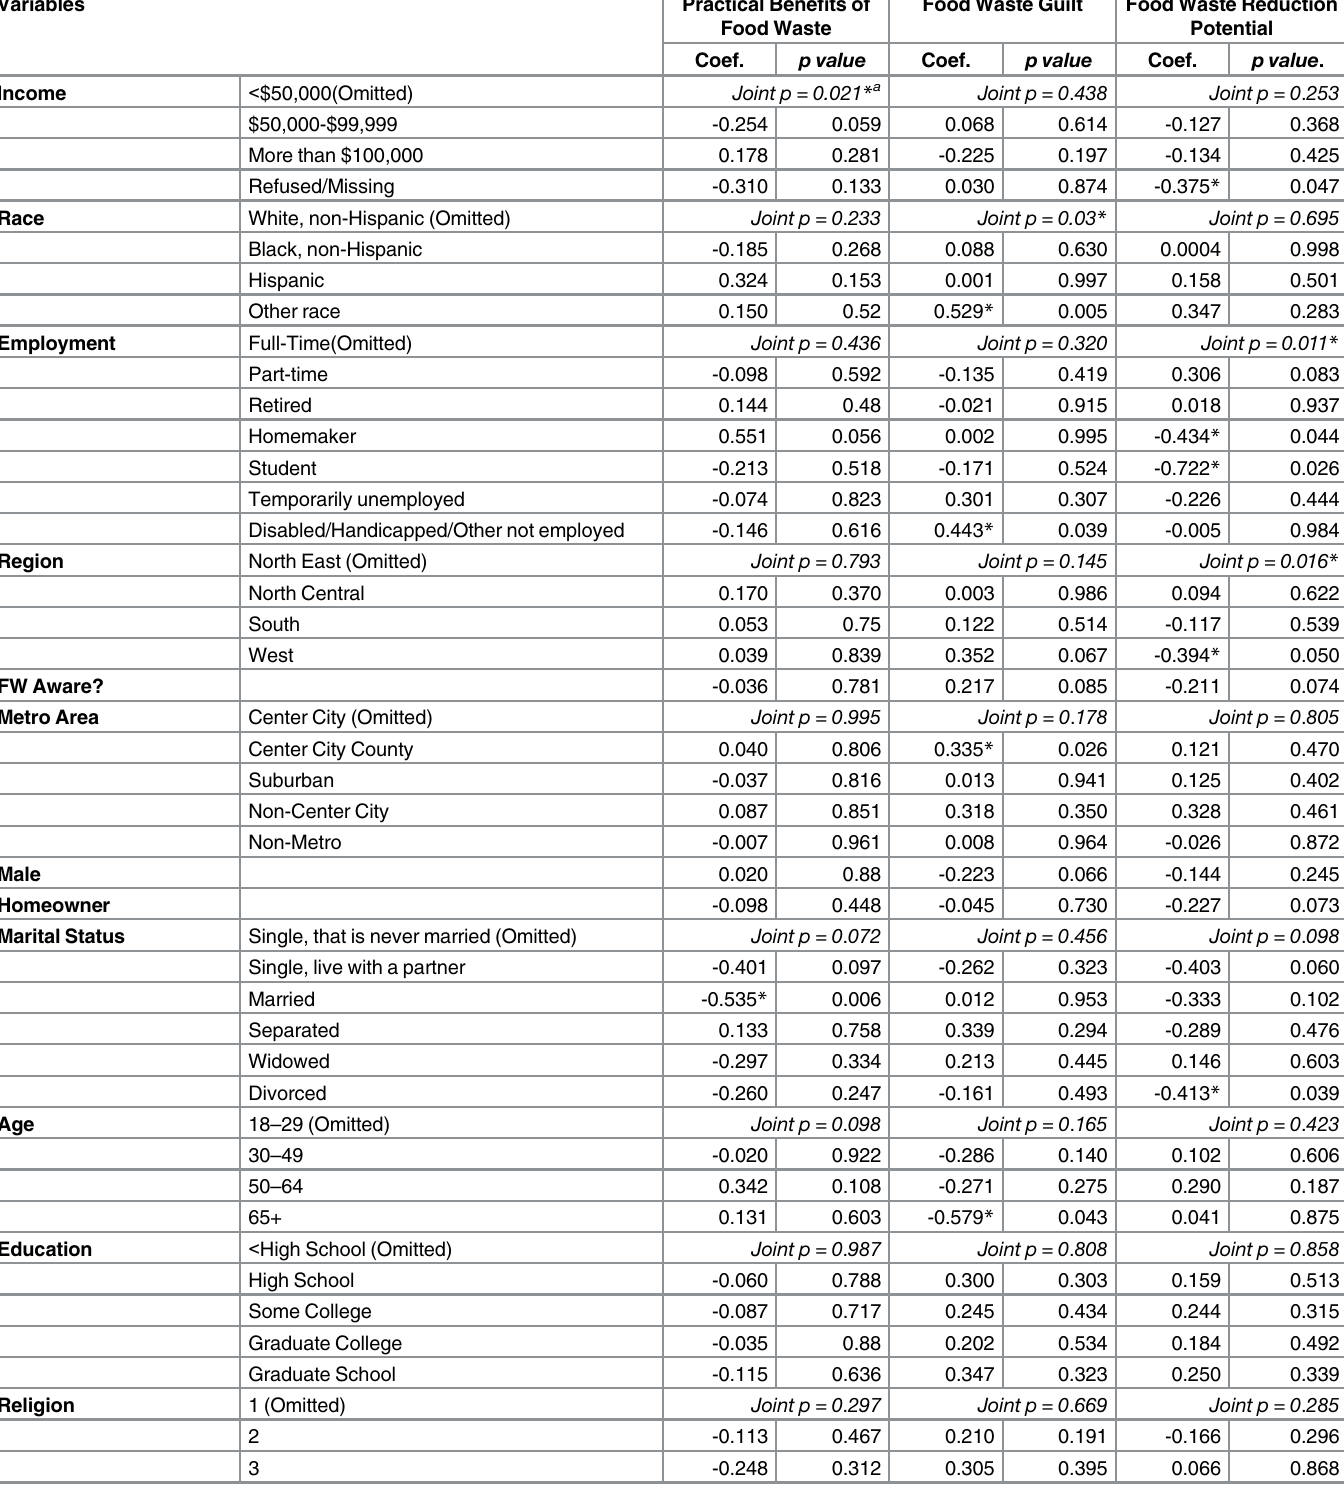
Table 3. Regression models of principal